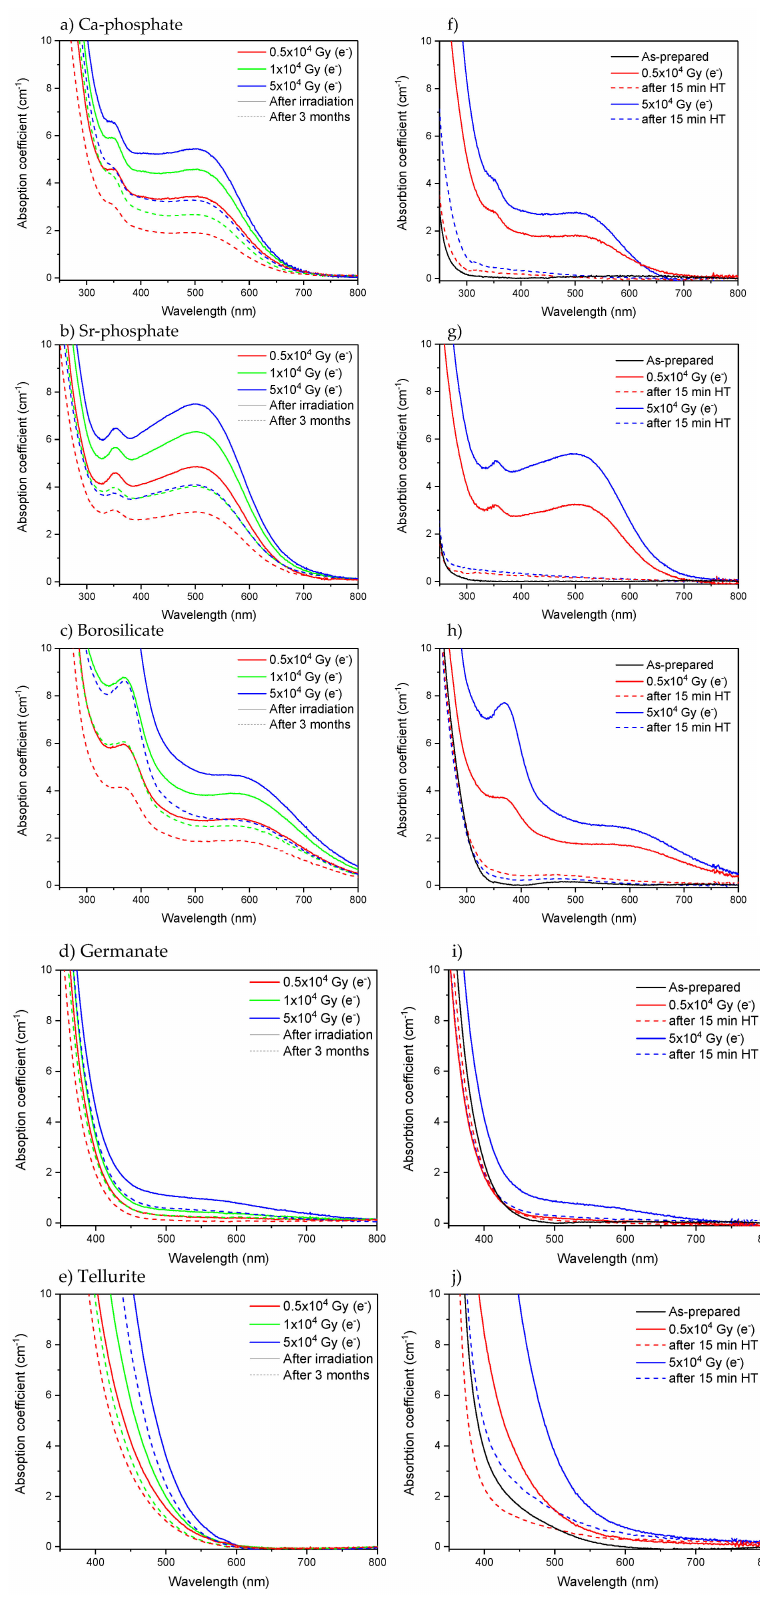
Figure 6. Absorption spectra of Ca-phosphate, Sr-phosphate, borosilicate, germanate, and tellurite glasses measured after irradiation using electrons (solid line), measured 3 months after the irradiation ( a – e ) and measured after heat treatment (HT) at T g for 15 min ( f – j ) (dashed